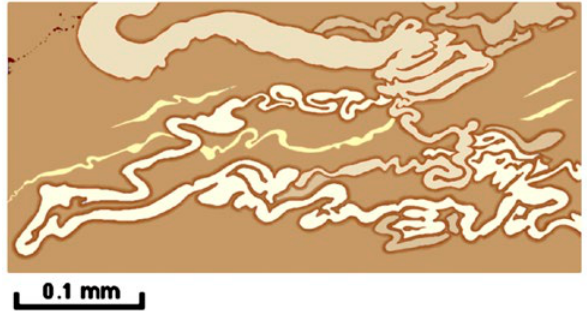
Figure 70. Ptygmatic micro-chert veins in a laminated matrix chert show the ‘loopy’ nature of the fluid precursor silica gel injected into a precursor ooze. Both matrix and ptygmatic veinlets are metacol- loidal chert so the difference at the time the precursor was injected is in the gel structure or consistency - plastic gel and non-Newto- nian fluid. The shear thinning property of the fluid silica polymer causes the looping and bulging. This specimen from Richie Lake 17 , Sokoman Iron-formation is illustrated by Dimroth and Chauvel (1973, p. 122).